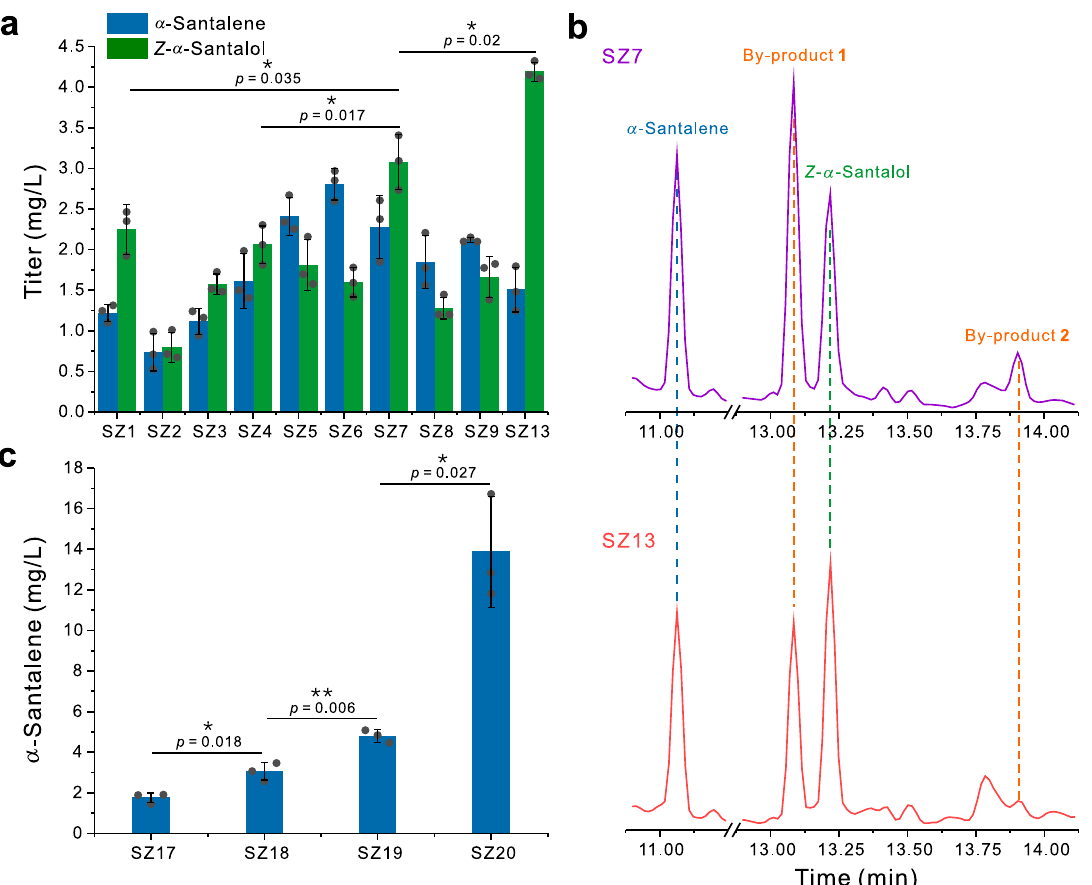
Fig. 5 Metabolic engineering of yeast for the production of santalenes and santalols. a The production of α -santalene and Z - α -santalol by expression of SanSyn and CYP736A167 assisted with the different CPRs in the yeast hosts (SZ1-SZ9, see Supplementary Data 1), and enhanced the production of α - santalene and Z - α -santalol by knockout of OYE2, OYE3, ATF1, and ATF2 (SZ13, see Supplementary Data 1). b GC-MS analysis of α -santalene, Z - α -santalol, dihydro- α -santalol (by-products 1) and acetyl dihydro- α -santalol (by-product 2) before and after knockout of OYE2, OYE3, ATF1, and ATF2 (SZ7 and SZ13, see Supplementary Data 1). c Enhanced the production of α -santalene by overexpression of IDI1, UPC2-1, ADH2, ALD6, and ACS L641P , and knockdown of ERG9 (SZ18 − SZ20, see Supplementary Data 1). All data represent the mean of n = 3 biologically independent samples and error bars show standard deviation. Statistical analysis was performed by using two-tailed and two-sample unequal variance t test (* P < 0.05, ** P < 0.01). Source data are provided as a Source Data fi